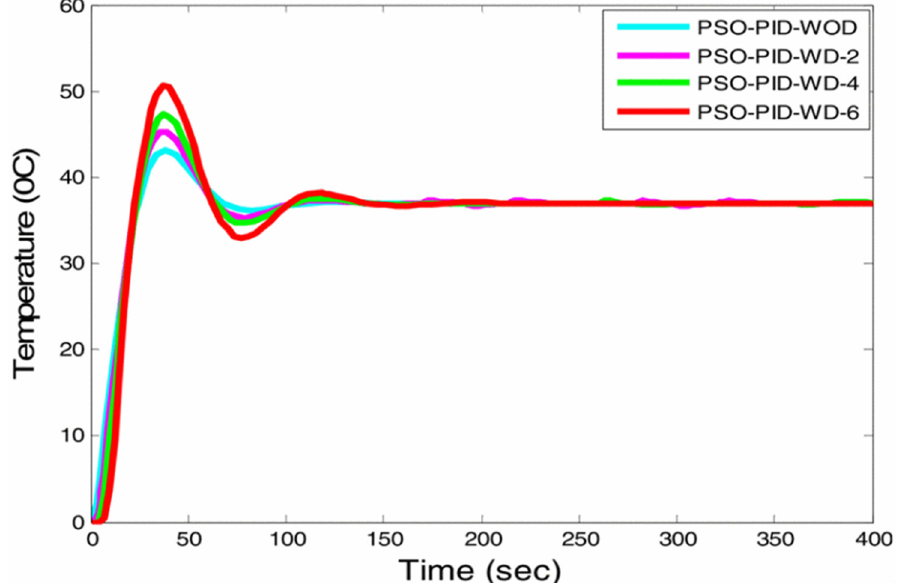
Figure 11. Ambulance output comparison plot with PSO, along with PID, in terms of time and temperature.